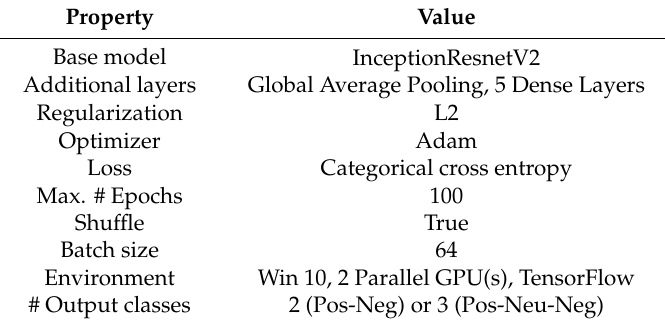
Table 2. The training parameters of network.